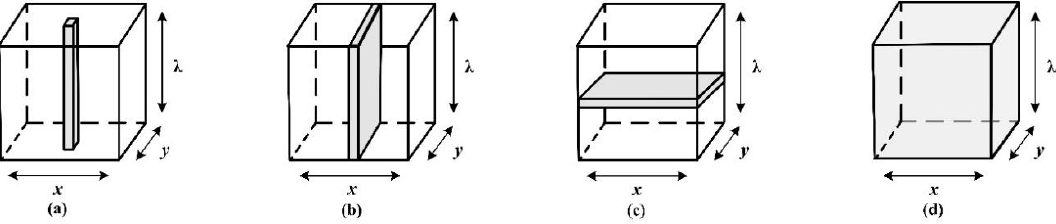
Figure 1. Four approaches to acquiring a three-dimensional hyperspectral image cube: ( a ) point scanning, ( b ) line scanning, ( c ) area scanning and ( d ) single shot, where x and y represent the spatial dimensions, while λ is the wavelength.